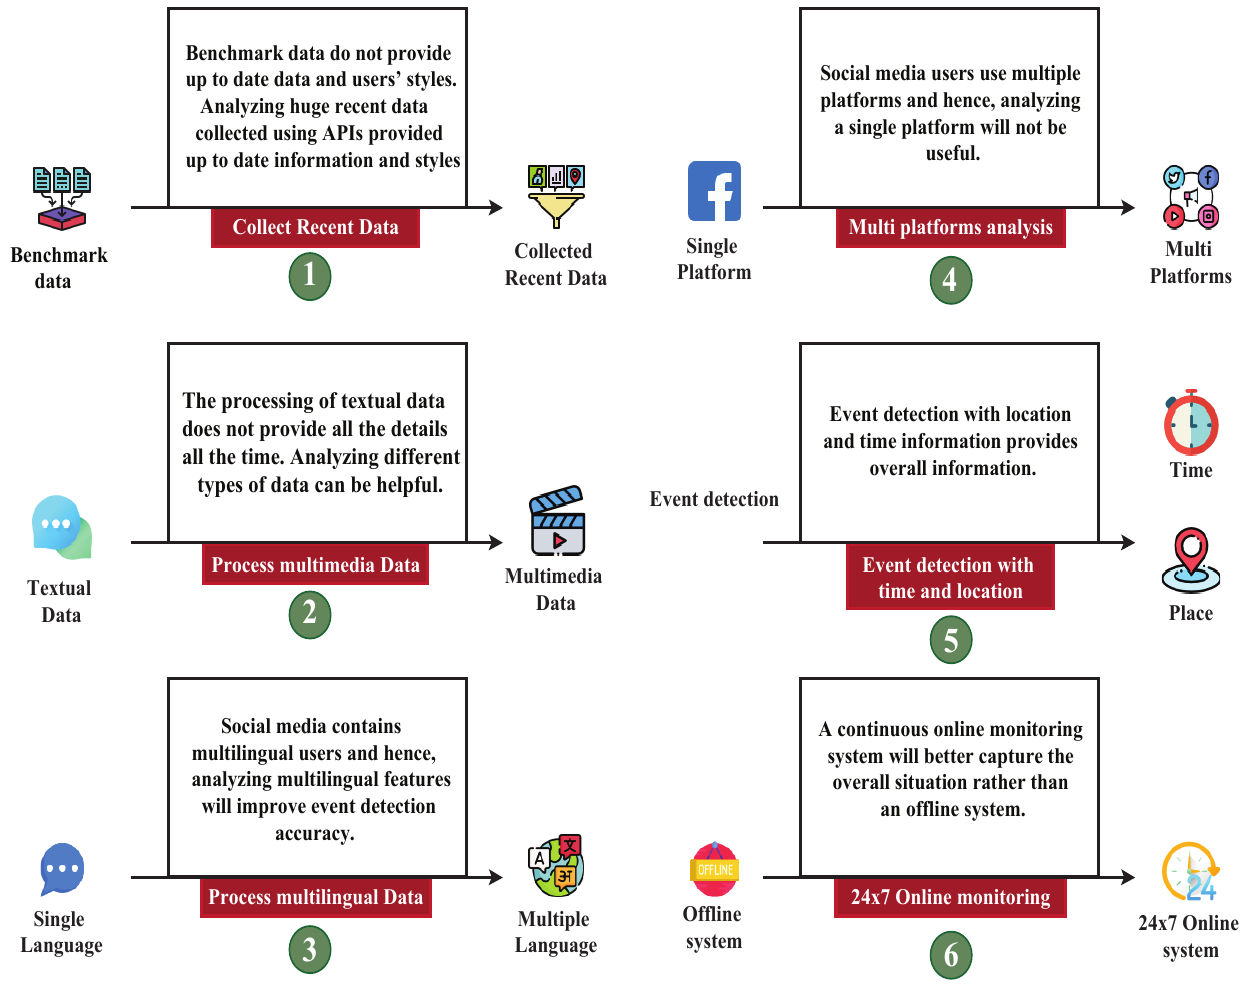
Figure 9. Challenges faced in event detection and solutions for their